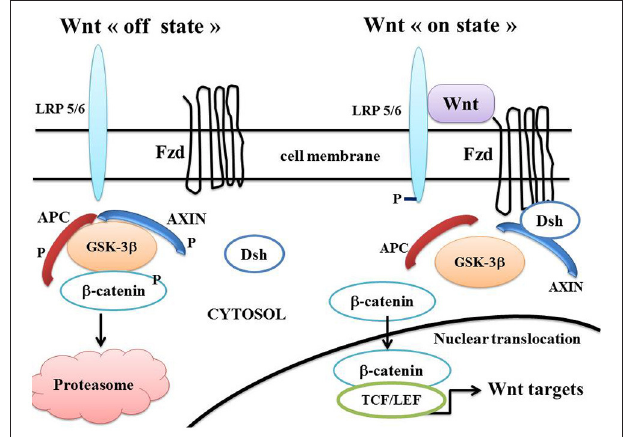
FIGURE 1 | A schematic model of the Wnt/beta-catenin pathway. In the Wnt “on state” (right part), Wnt binds both Fzd and LRP5/6 receptors to initiate LRP phosphorylation as well as Dsh/Fzd internalization. Dsh membrane translocation leads to dissociation of the axin/APC/GSK-3 β complex. Beta-catenin phosphorylation is inhibited and it accumulates in the cytosol. The cytosolic beta-catenin translocates to the nucleus and binds to TCF/LEF factors. This results in the Wnt-responsive gene transcription. In Wnt “off state” (left part), Dsh dissociates from Fzd and Axin. APC and axin complex with GSK-3 β . Beta-catenin is phosphorylated, dissociates from GSK-3 β , migrates to the cytosol and is destroyed in the proteasome. Abbreviations: APC, adenomatous polyposis coli; Dsh, Disheveled; Fzd, Frizzled; GSK-3 β , glycogen synthase kinase-3beta; LRP5/6, low density lipoprotein receptor-related protein 5/6; TCF/LEF, T-cell factor /lymphoid enhancer